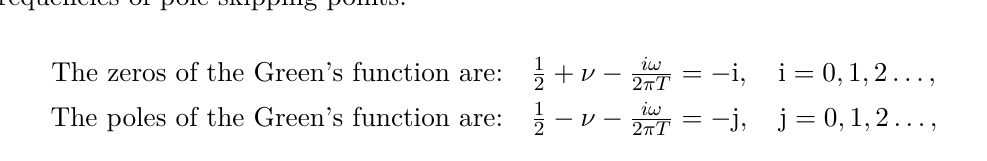
Figure 8 . The first three order pole-skipping points of scalar field φ ( ζ ) in AdS 2 × R d − 1 geometry (a) d = 3 , ζ 0 = 1 , R 2 = − 1 √ ; (b) d = 2 , ζ 0 = 1 , R 2 = − 1 √ 6 of frequencies of pole-skipping